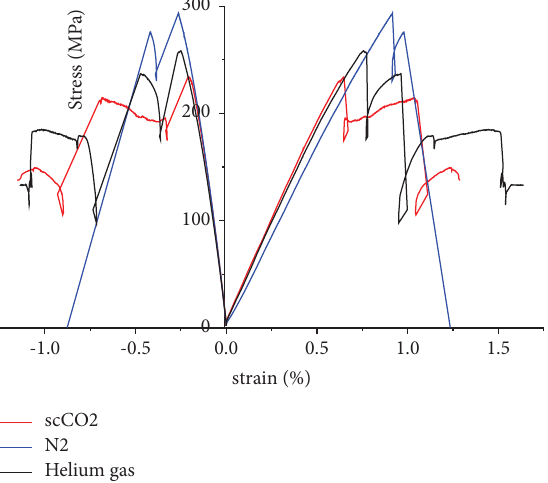
Figure 9: Stress-strain curves at the coring angle of 75 °